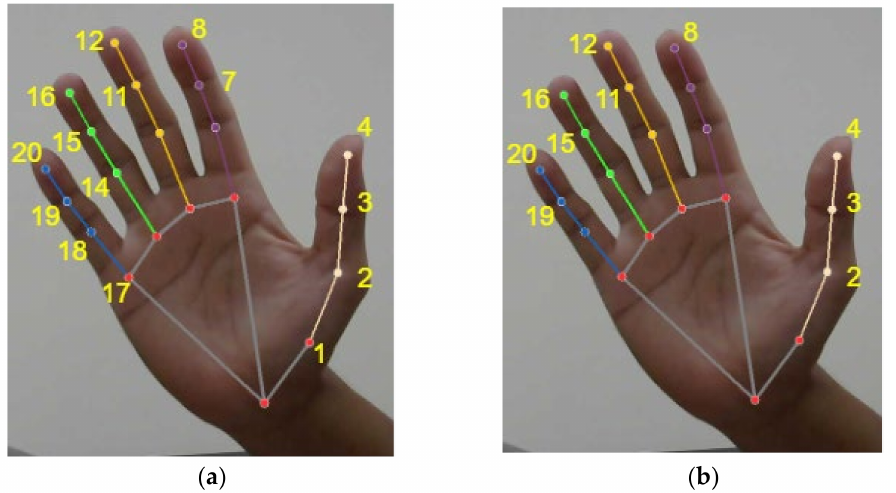
Figure 10. Hand landmarks selected using RFE. Eliminated landmarks are not shown in the figure. ( a ) 15 features, ( b ) 10 features.